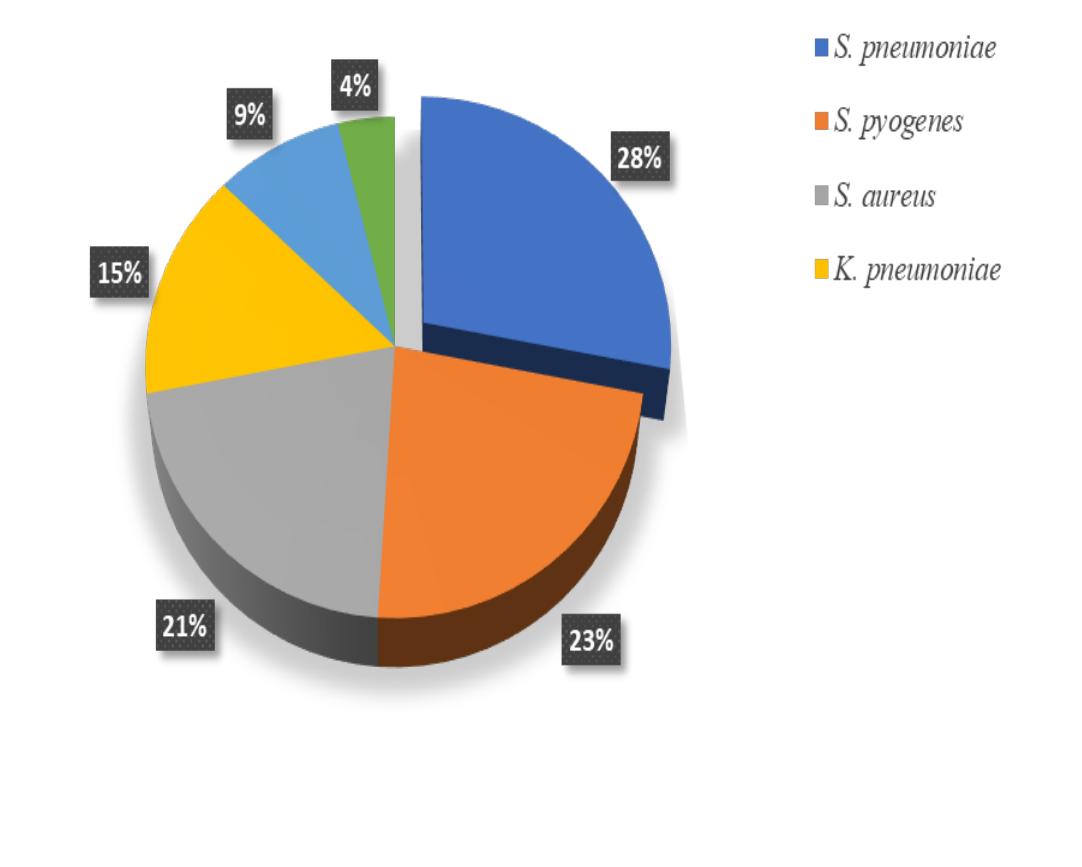
Figure 3. Percentage occurrence of bacteria isolated from throat